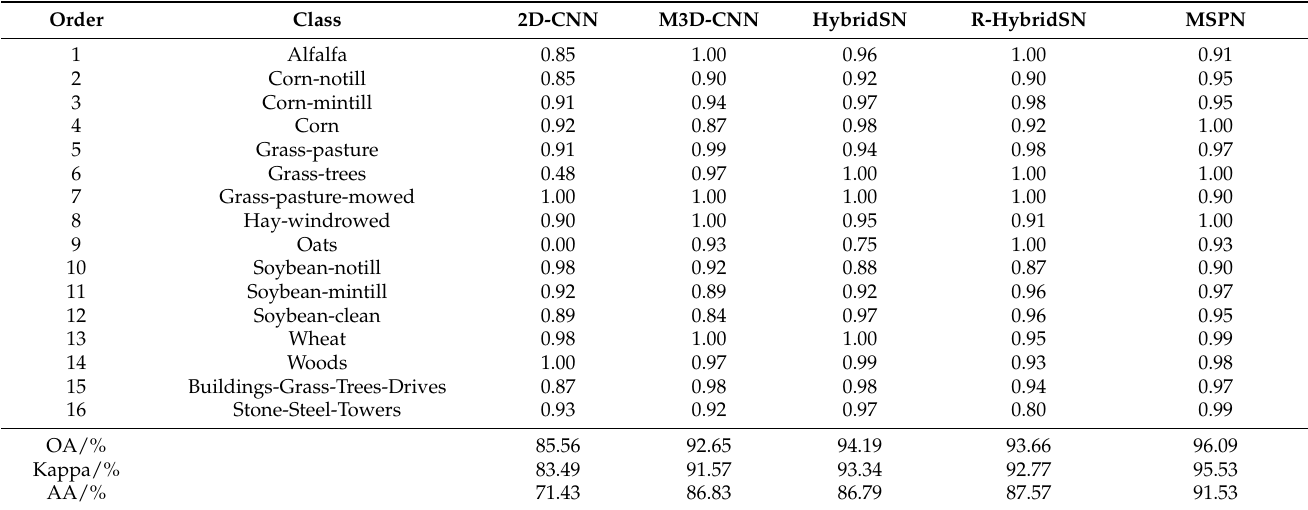
Table 2. Accuracy comparison of different methods for 5% samples of Indian Pine.